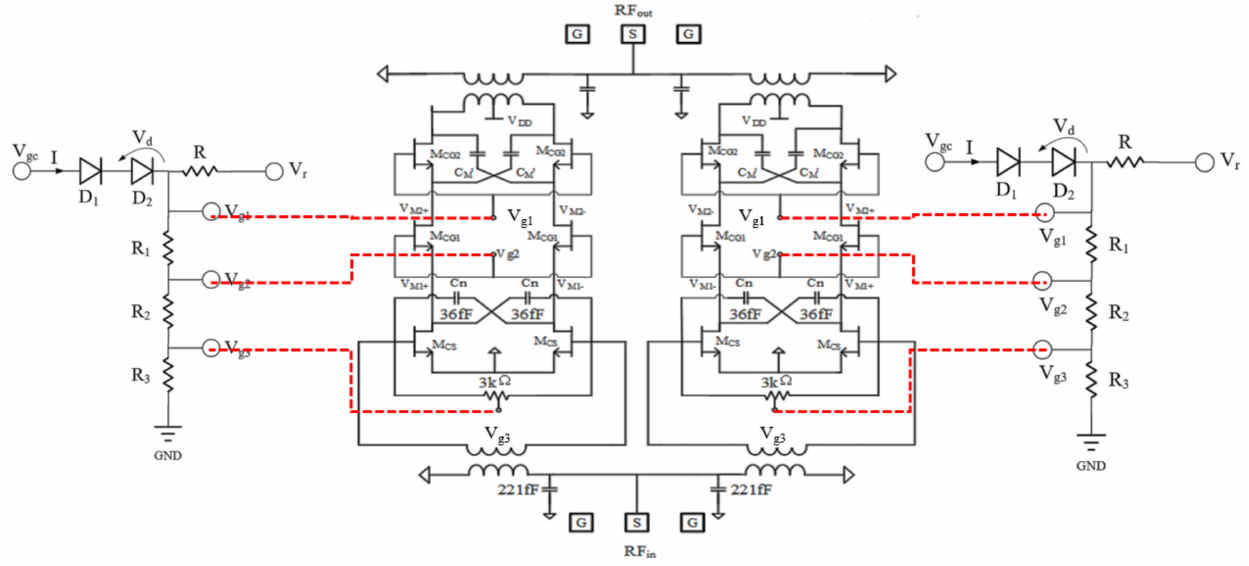
Figure 3. Schematic diagram of differential stacked PA, based on temperature compensation